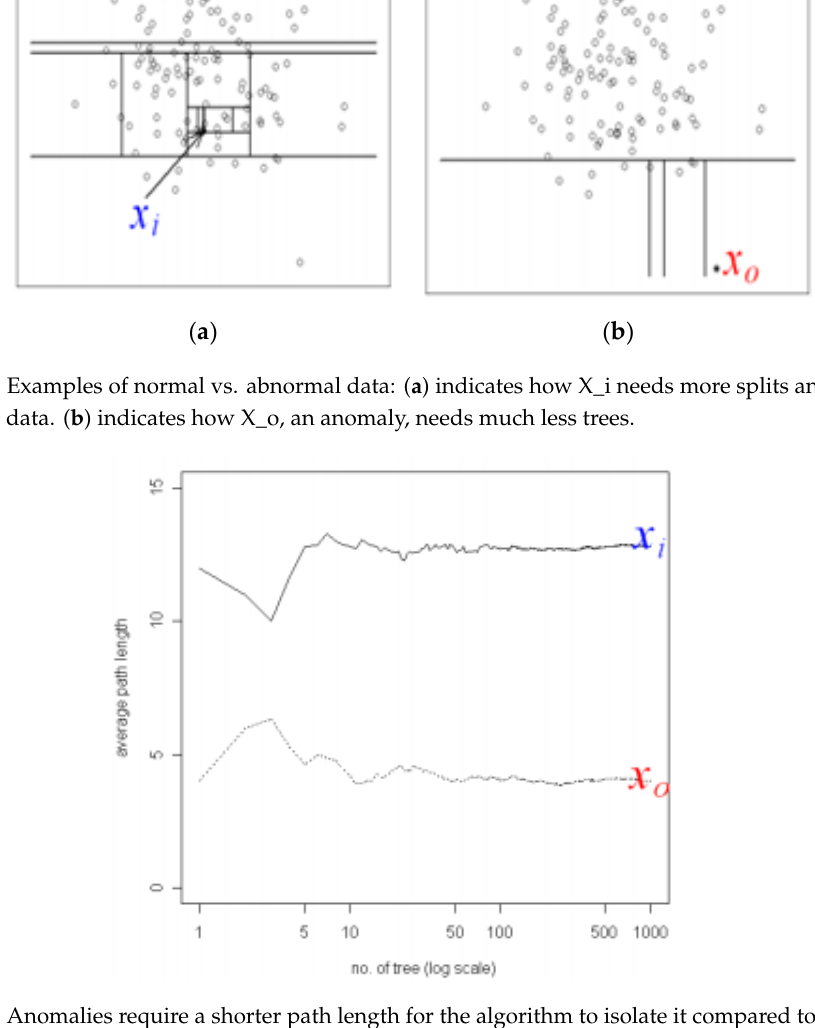
Figure 5. Anomalies require a shorter path length for the algorithm to isolate it compared to a normal data point.